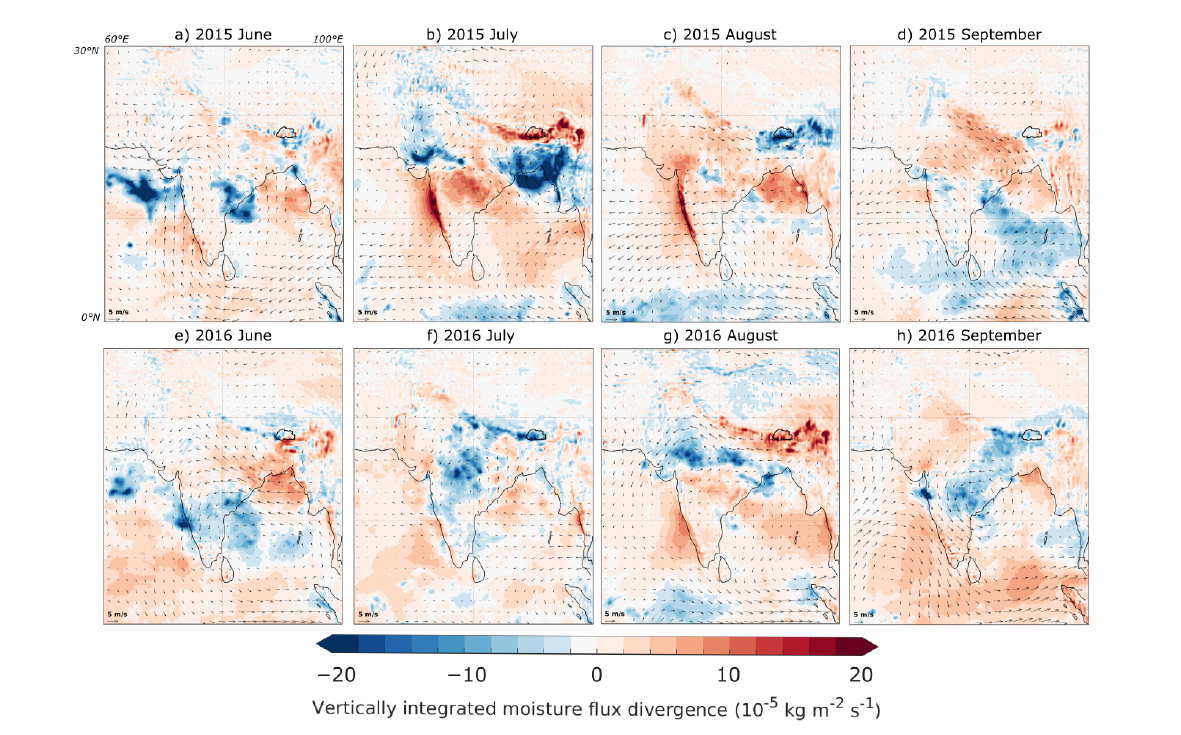
Figure 7. The anomaly behavior of vertically integrated moisture flux divergence (kg m − 2 s − 1 ) and horizontal wind (m/s) at the 850 hPa during the monsoon seasons of 2015 and 2016. The mean monthly 2015 and 2016 difference of vertically integrated moisture flux divergence and horizontal wind is displayed for June, July, August, and September, calculated by subtracting the 2015 and 2016 monthly values from the 40-year climatology period of 1979 to